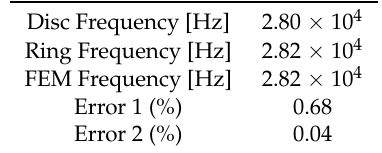
Table 1. Validation analytic design vs. FEM.